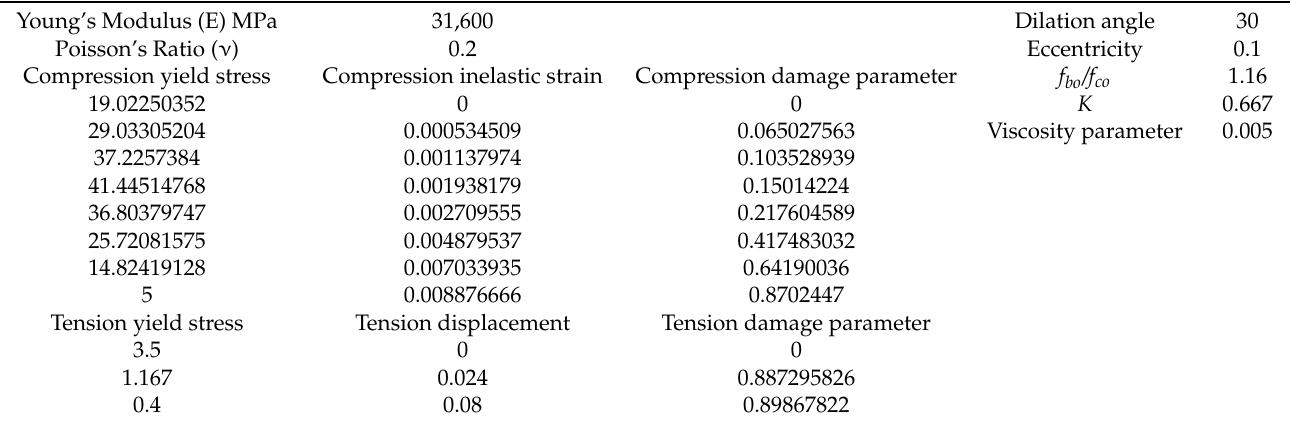
Table 8. CDP model for NSC concrete ( f c (cid:48) = 30 MPa).